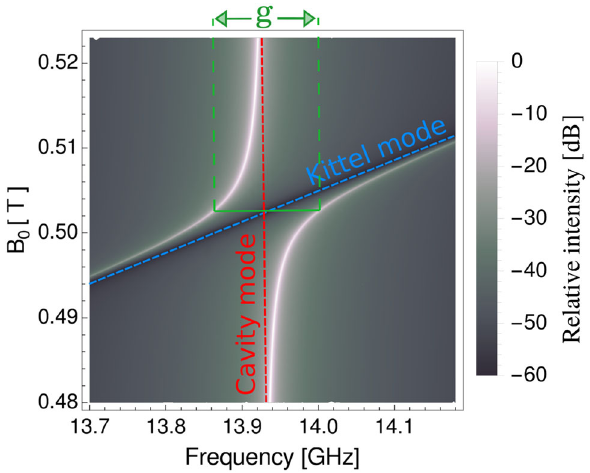
Fig. 1 Transmission spectrum of the hybrid system as a function of the external field B 0 , showing the anticrossing curve of the cavity mode (red dashed line) and Kittel mode (blue dashed line). The coupling g is defined by Eq.